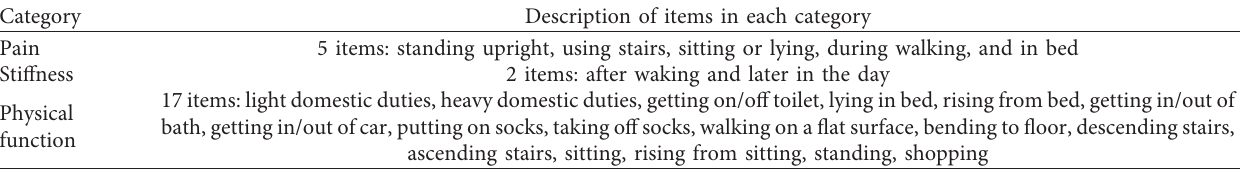
Table 2: Overview of the Western Ontario and McMaster Universities Osteoarthritis Index scoring system (WOMAC). Items in each category are assigned a numerical score from zero to four, with higher scores indicating greater disability. Category Description of items in each category